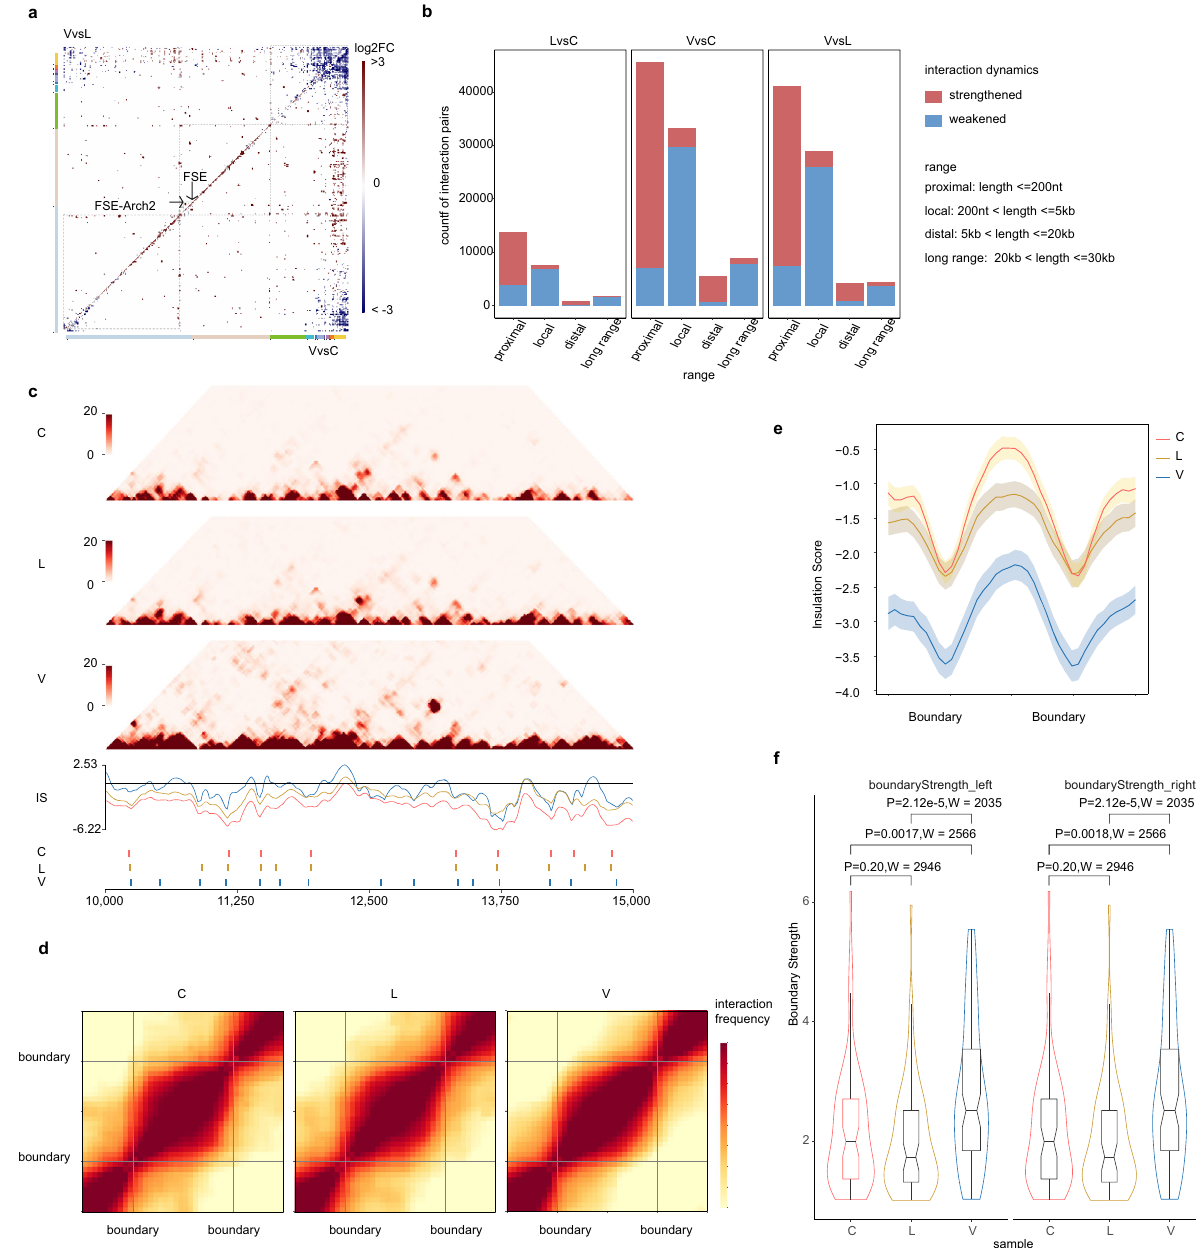
Fig. 4 Dynamic structures in different phase of viral cycle. a Heatmaps showing comparisons of RNA – RNA interactions in virions vs. cells (VvsC) and virions vs. lysates (VvsL). VvsL is in the upper quadrant and VvsC is in the lower quadrant. b Differential interactions were classi fi ed according to spans as indicated. Bar plots shows number of strengthened or weakened interactions in each category. c RNA interaction maps (Top) binned at 10 nt resolution show interactions 10 – 15 kb on SARS-CoV-2 genome in C, L, and V samples. Line plots (median) show insulation pro fi les. Short lines (bottom) re fl ect boundaries. d Maintenance of domains during SARS-CoV-2 virus life cycle. Heatmaps showing the normalized average interaction frequencies for all boundaries as well as their nearby regions (±0.5 domain length) in C, L, and V samples. The heatmaps were binned at 10 nt resolution. e The average normalized insulation scores were plotted around boundaries from 1/2 domain upstream to 1/2 domain downstream and divided into 40 bins. Shadowed area show SE bands at each bin. n = 76, 71, and 96 domains in C, L, and V samples. f Violin plot compare boundary strength among C, L, and V samples. Showing higher boundary strength in V samples. Boxplots show largest (upper whisker), smallest (lower whisker), 50% quantile (center), upper hinge (75% quantile), and lower hinge (25% quantile). Comparisions were made by two-sided two-sample Wilcoxon ’ s rank-sum test, no multiple comparisons adjustment was made. P -value and Wilcoxon ’ s rank-sum test statistics W were indicated. n = 76, 71, and 96 domains in C, L, and V